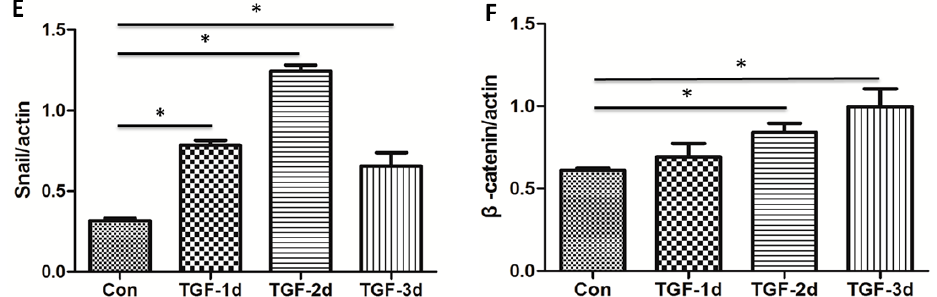
Figure 2. TGF- β induces the alteration of EMT-related genes in A549 cells. A549 cells were exposed to 5 ng/mL TGF- β for 0, 1, 2, and 3 days. ( A ) Western blot analysis of E-cadherin, N-cadherin, Vimentin, β -catenin, and Snail. β -actin served as a loading control; ( B – F ) the levels of the indicated protein was quantified with gray value (Mean ± SD, n = 3). * p < 0.05 compared with the corresponding group.